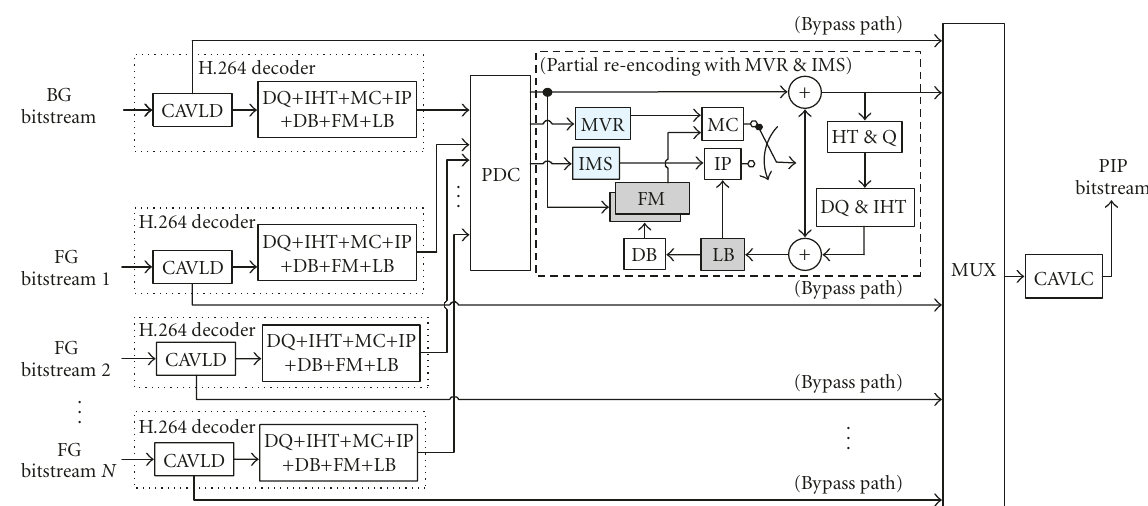
Figure 5: Intermediate architecture of RFMT with the MVR and the IMS